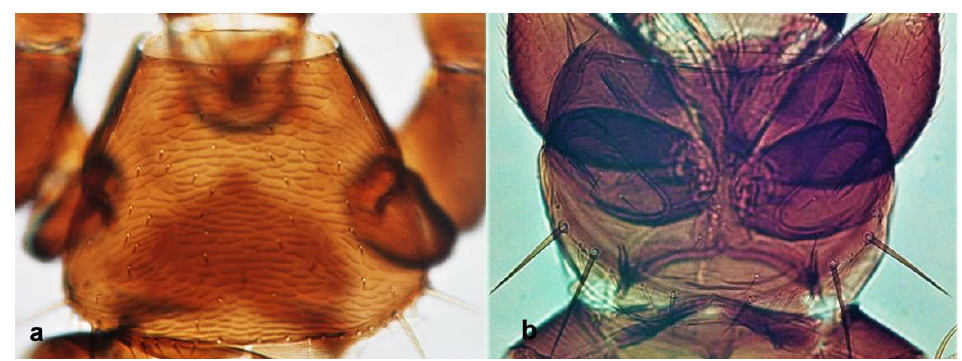
Figure 20. Pronotum: ( a ) considerably narrower at anterior margin than at posterior margin; ( b ) being almost the same width at both margins. 20 Antennal segment II symmetrical .................................... Chirothrips hamatus Trybom Antennal segment II asymmetrical, projecting laterally (Figure 21a,b) .....................